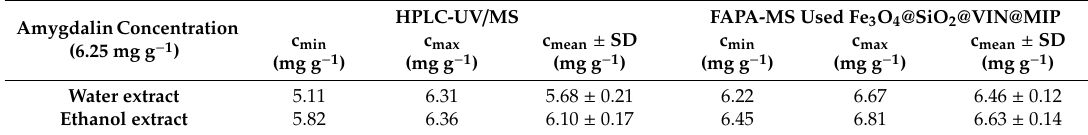
Table 4. Results of amygdalin determination in apricot kernels (6.25 mg g − 1 ) by HPLC-UV/MS and FAPA-MS methods.